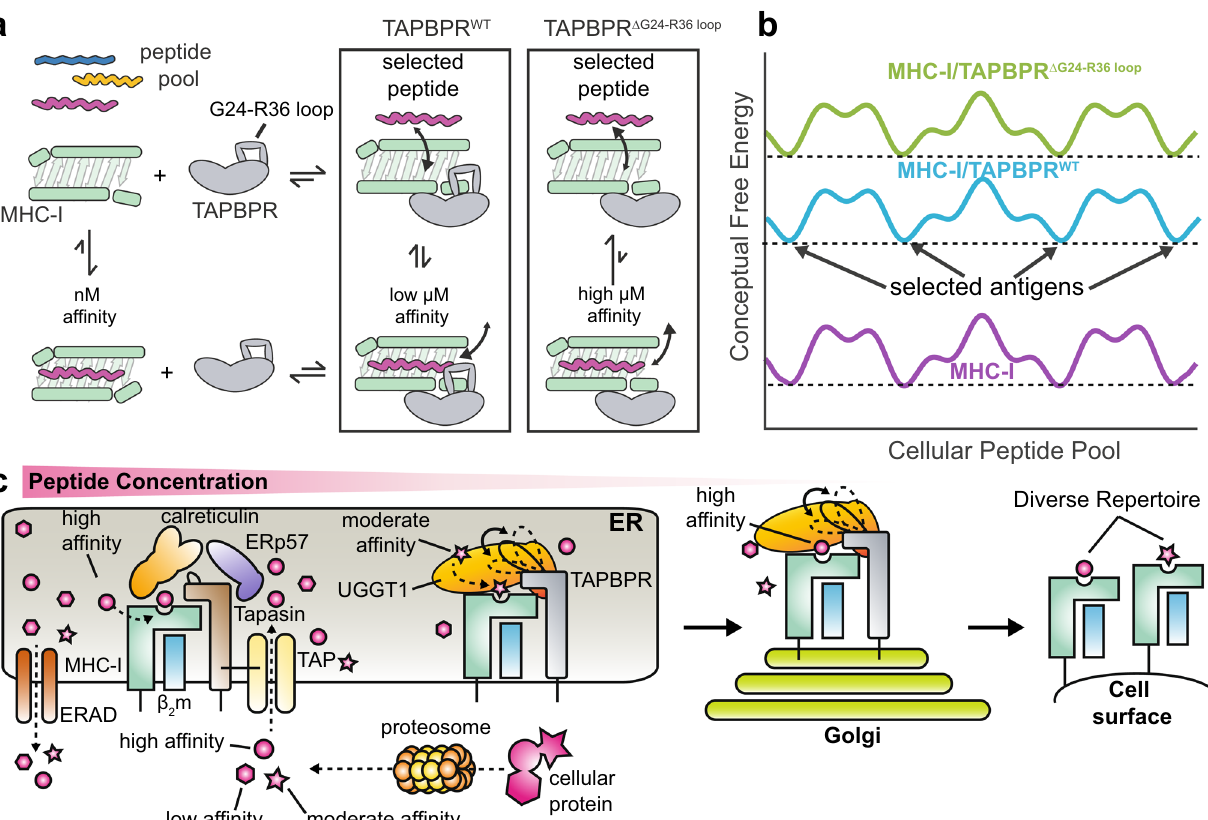
Fig. 7 Proposed model of auxiliary peptide editing functions of TAPBPR. a Schematic of how the TAPBPR G24-R36 loop in fl uences the peptide exchange cycle. The G24-R36 loop serves as a trap, promoting peptide binding on the MHC-I/TAPBPR complex with low μ M af fi nity. When TAPBPR is mutated to have a shorter loop, the af fi nity of peptides is reduced to high μ M range. b Conceptual example of the free energy landscape across the cellular peptide pool. The TAPBPR G24-R36 loop shapes the selected peptide repertoire by stabilizing peptide binding across the cellular pool, functioning as an auxiliary loading chaperone for peptides of low and moderate af fi nity. c In the ER, peptide selection is governed both by the effective concentration of peptides and the absence (in tapasin) or the presence of the kinetic trap (in TAPBPR). Tapasin is tethered to the TAP transporter and because it is restricted to an environment of high peptide concentration and has a shorter loop, it primarily loads high-af fi nity peptides. In contrast, TAPBPR is not tethered to TAP and because it functions in environments of lower peptide concentration, it employs a trap to load both high and moderate af fi nity peptides and/or to minimize dissociation of peptides during transient TAPBPR/pMHC-I interactions. This process results in a diverse peptide repertoire being displayed by MHC-I molecules on the cell